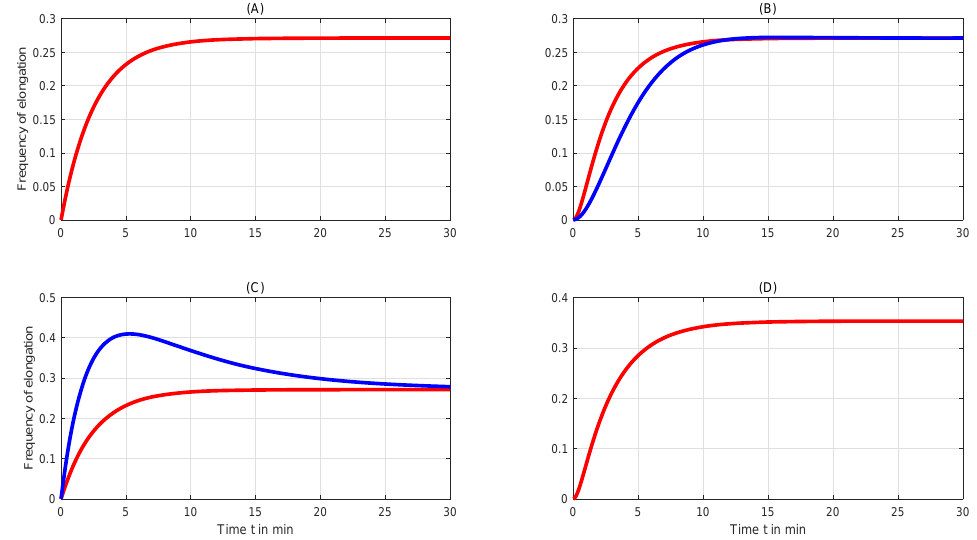
Figure 2. The temporal profiles of elongation frequency in different transcription systems; ( A ) two- state transcription system; ( B ) three-state transcription system; ( C ) the cross-talking transcription system; ( D ) two-ON transcription